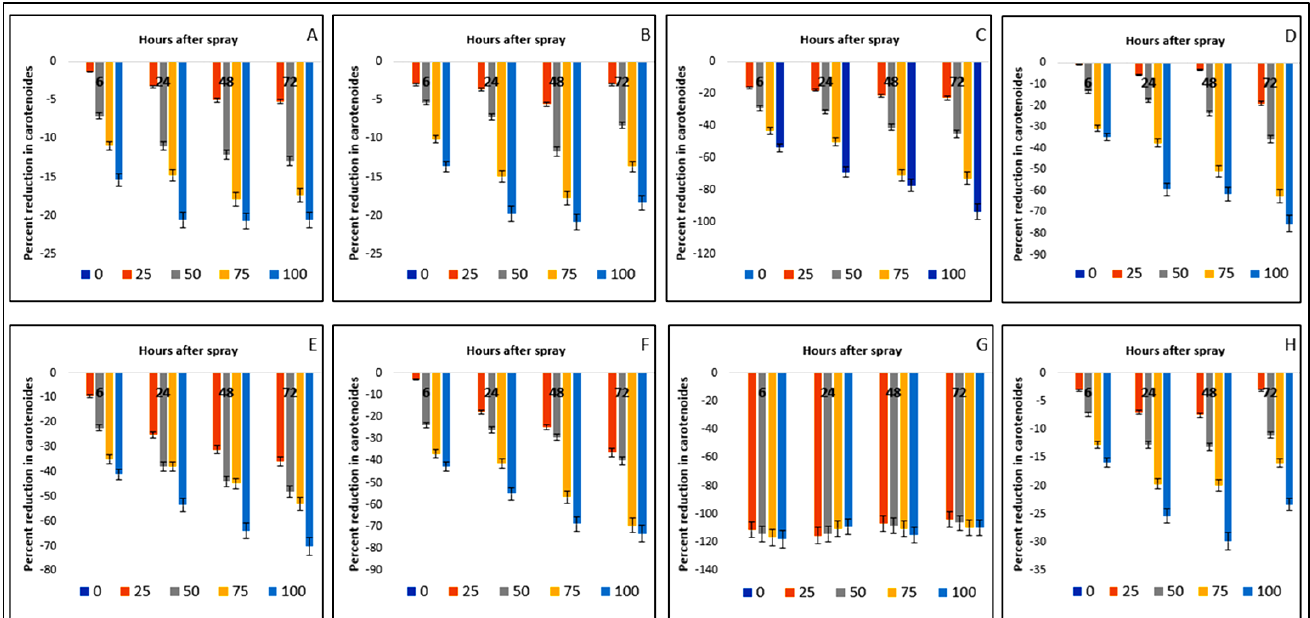
Figure 6. Surface plot of total chlorophyll vs. concentration hours as a consequence of parthenium leaf methanol extract on several crops and weeds: ( A ) -Bambara groundnut; ( B ) -Maize; ( C ) - D. san- guinalis ; ( D ) - E. indica ; ( E ) - A. conyzoides ; ( F ) - C. iria ; ( G ) - E. hirta , and ( H ) - C. difformis .